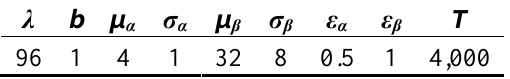
Table 1. Constants used in the